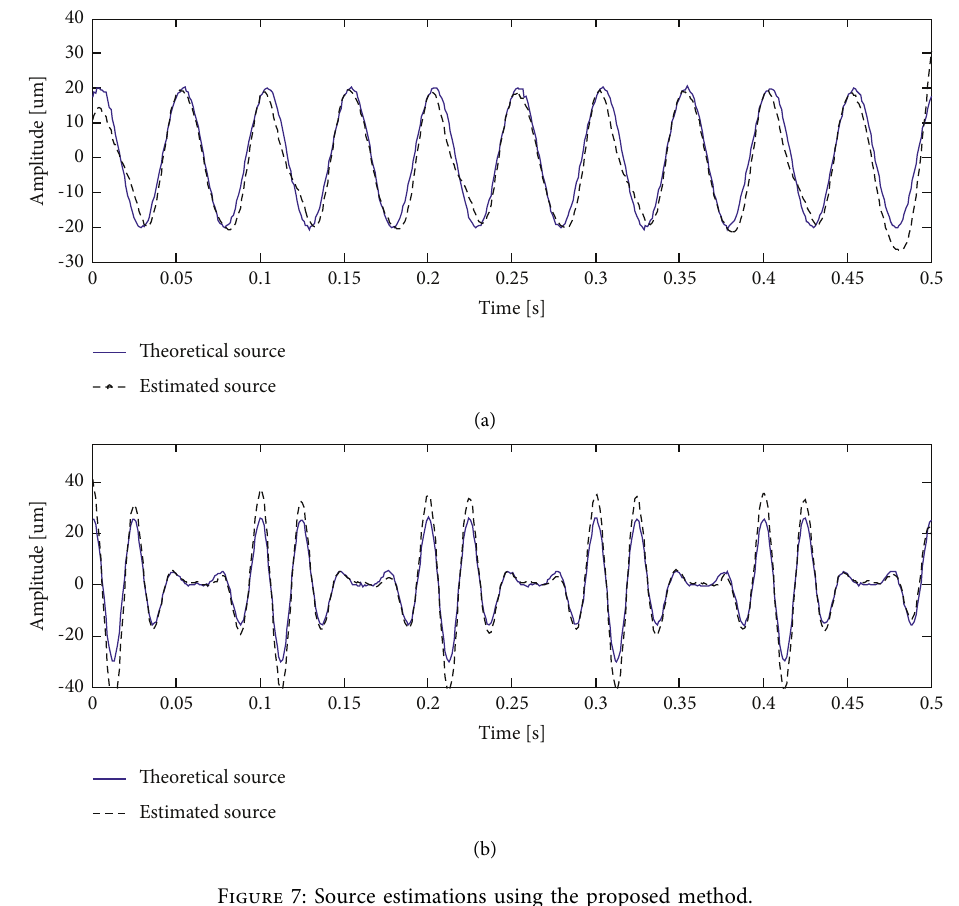
Figure 7: Source estimations using the proposed method.